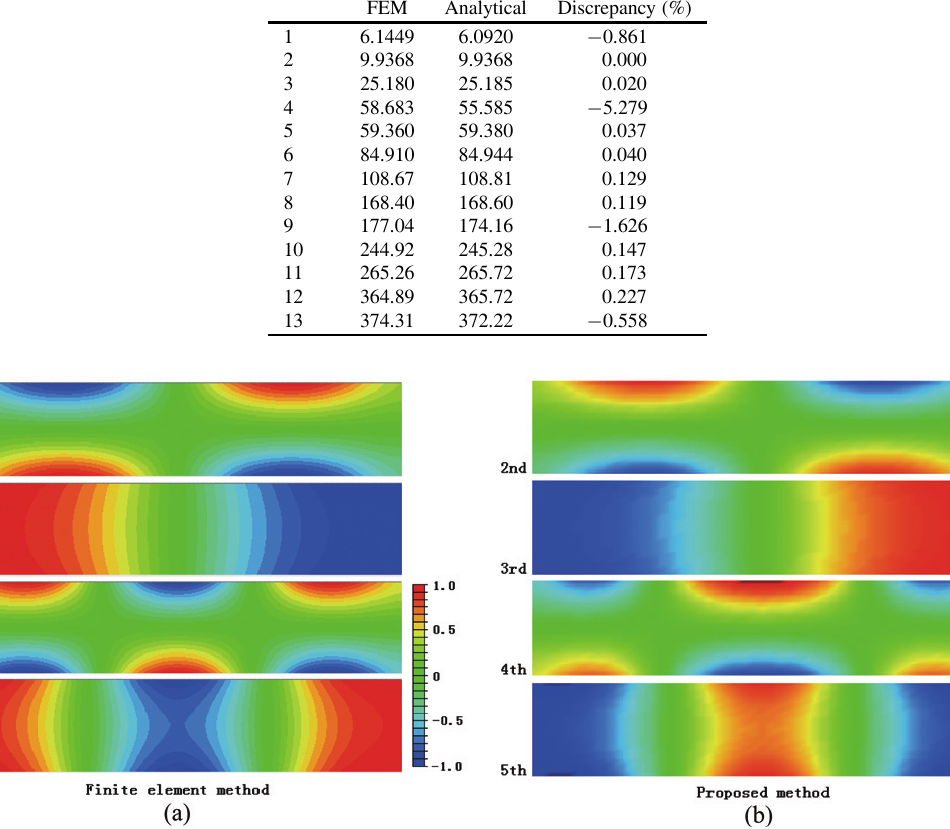
Fig. 3. Normalized pressure distribution at natural frequencies, computed with two different